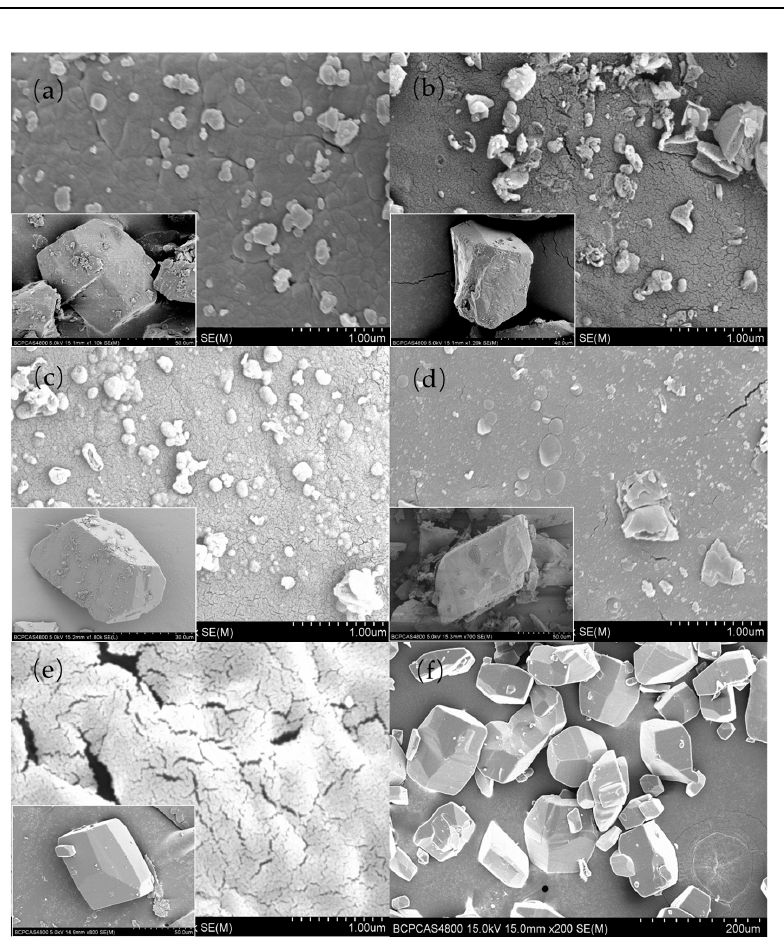
Figure 3. Scanning electron microscopy (SEM) images for (a) epsilon ‐ CL ‐ 20 ( ε‐ CL ‐ 20)/polydopamine (PDA), (b) ε‐ CL ‐ 20/poly ‐ L ‐ dopamine (PLD), (c) ε‐ CL ‐ 20/poly ‐ norepinephrine (PNE), (d) ε‐ CL ‐ 20/poly ‐ 6 ‐ hydroxydopamine (POHDA), and (e,f) ε‐ CL ‐ 20.